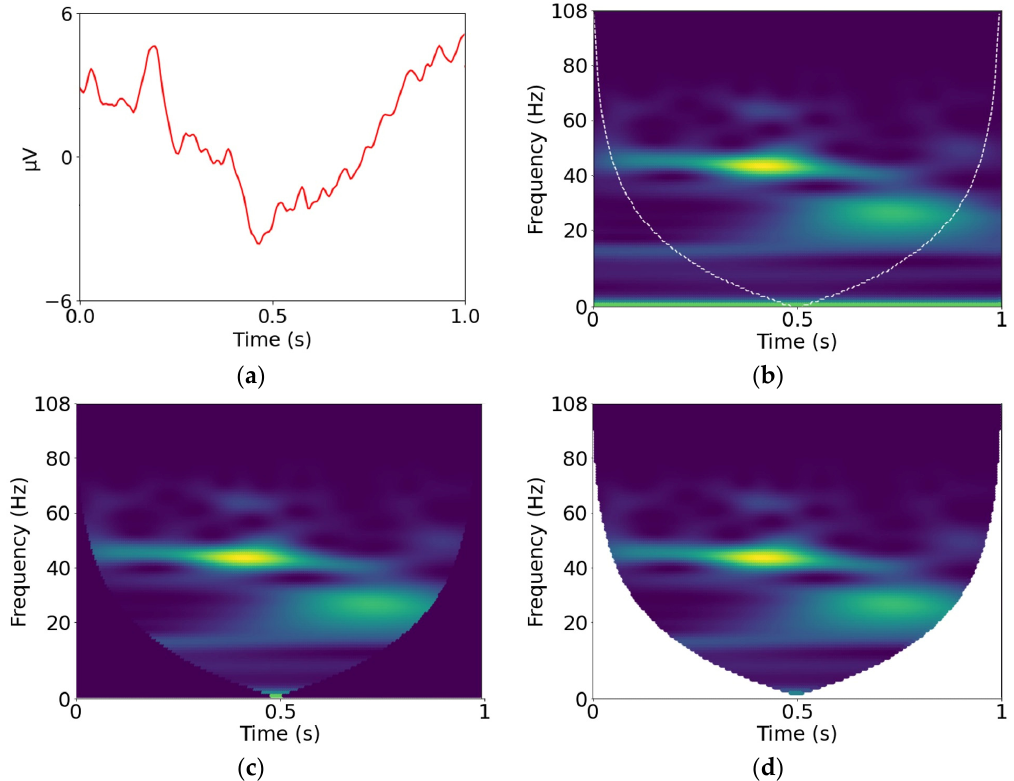
Figure 1. ( a ) ERP, ( b ) S-scalogram with superimposed COI, ( c ) Z-scalogram, ( d ) V-scalogram.